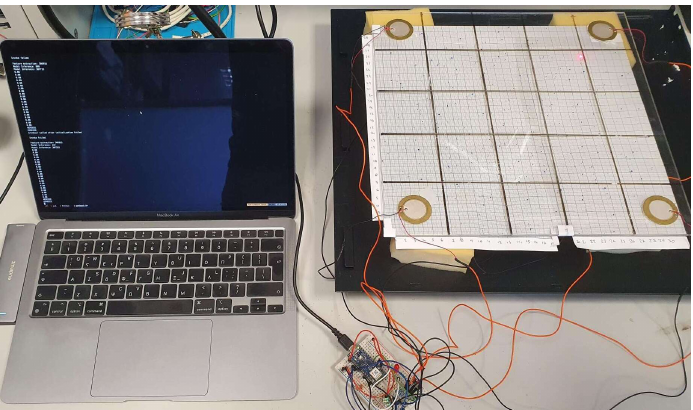
Figure 5. Image of the experimental plate setup.